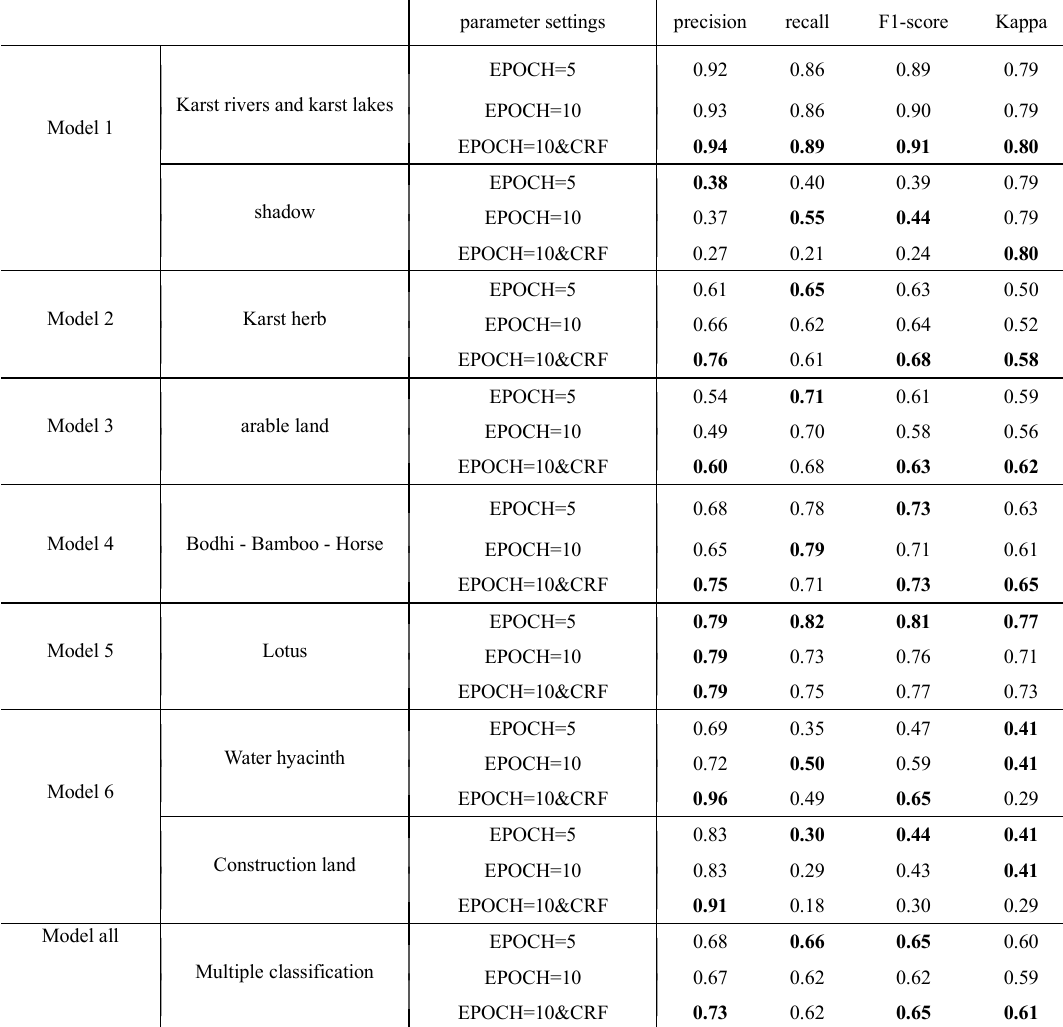
Table 1: EPOCH is different, whether to join the CRF model classification results accuracy